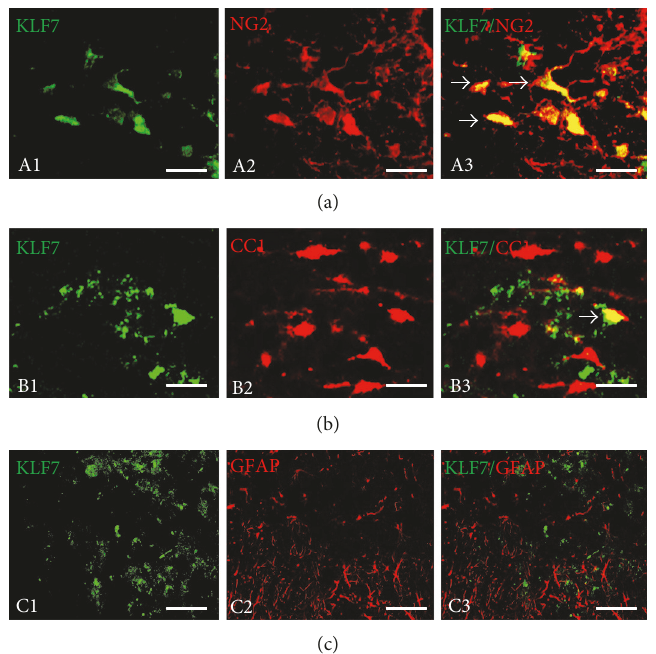
Figure 12: Cellular localization of KLF7 expression in the mouse spinal cord after spinal cord injury (SCI). (a) Little KLF7 immunoreactivity (IR) was localized in oligodendrocytes indicated by CC1 IR (arrows). (b) KLF7 immunoreactivity (IR) was localized in oligodendrocyte precursors indicated by NG2 IR (arrows). (c) No KLF7 immunoreactivity (IR) was localized in astrocytes indicated by GFAP IR (arrows). Scale bars: 100 μ m.